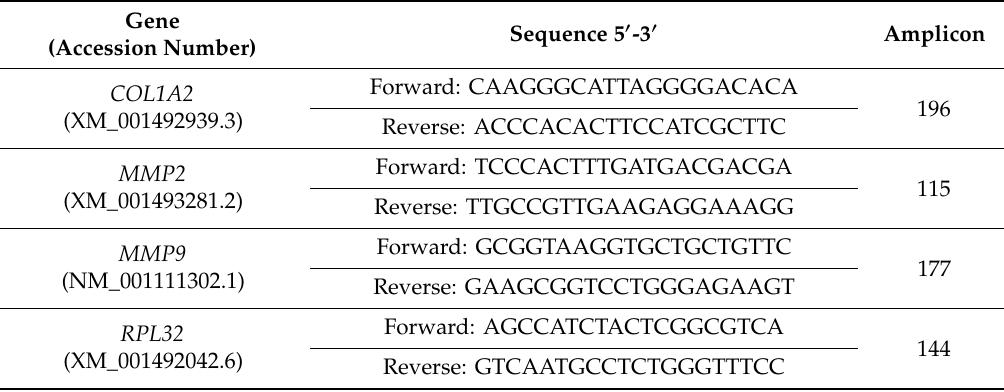
Table 1. Primers used in quantitative real-time polymerase chain reaction